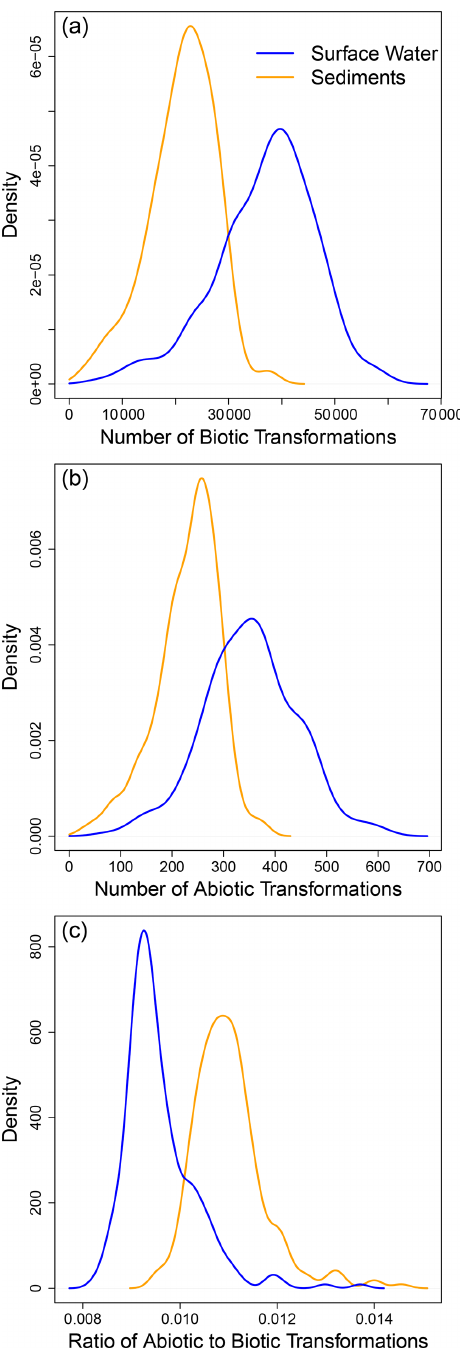
Figure 2. Examining the ConUS-scale distributions of biotic and abiotic transformation numbers reveals more transformations in sur- face water than sediment organic matter. Kernel density functions for ConUS-scale biotic (a) and abiotic (b) transformations and their ratio (c) in sediment (orange lines) and surface water (blue lines) organic matter. The median values of the distributions significantly diverge within each panel (see text for